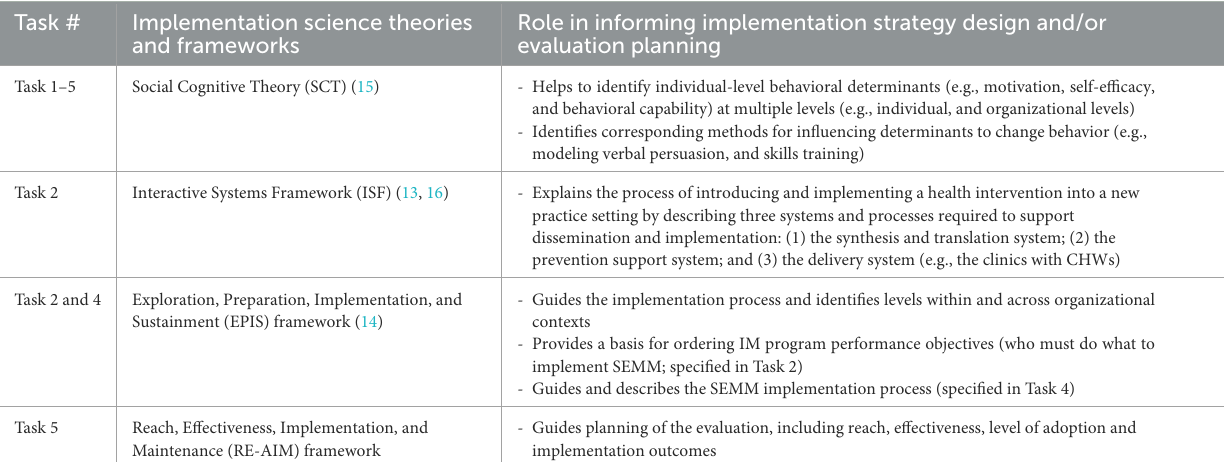
TABLE 1 Summary of theories, frameworks and models used to guide development of SEMM-DIA, an implementation